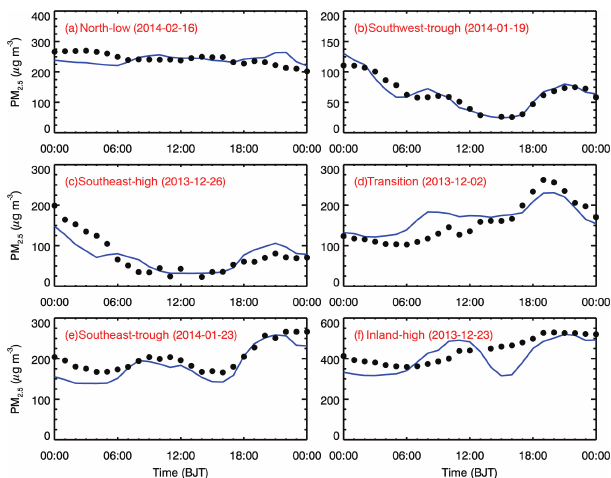
Figure 10. Comparison of observed and predicted diurnal profiles of the PM 2 . 5 mass concentrations averaged over the monitoring sites in the Guanzhong basin on (a) 16 February 2014 (“north- low”), (b) 19 January 2014 (“southwest-trough”), (c) 26 Decem- ber 2013 (“southeast-high”), (d) 2 December 2013 (“transition”), (e) 23 January 2014 (“southeast-trough”), and (f) 23 December 2013